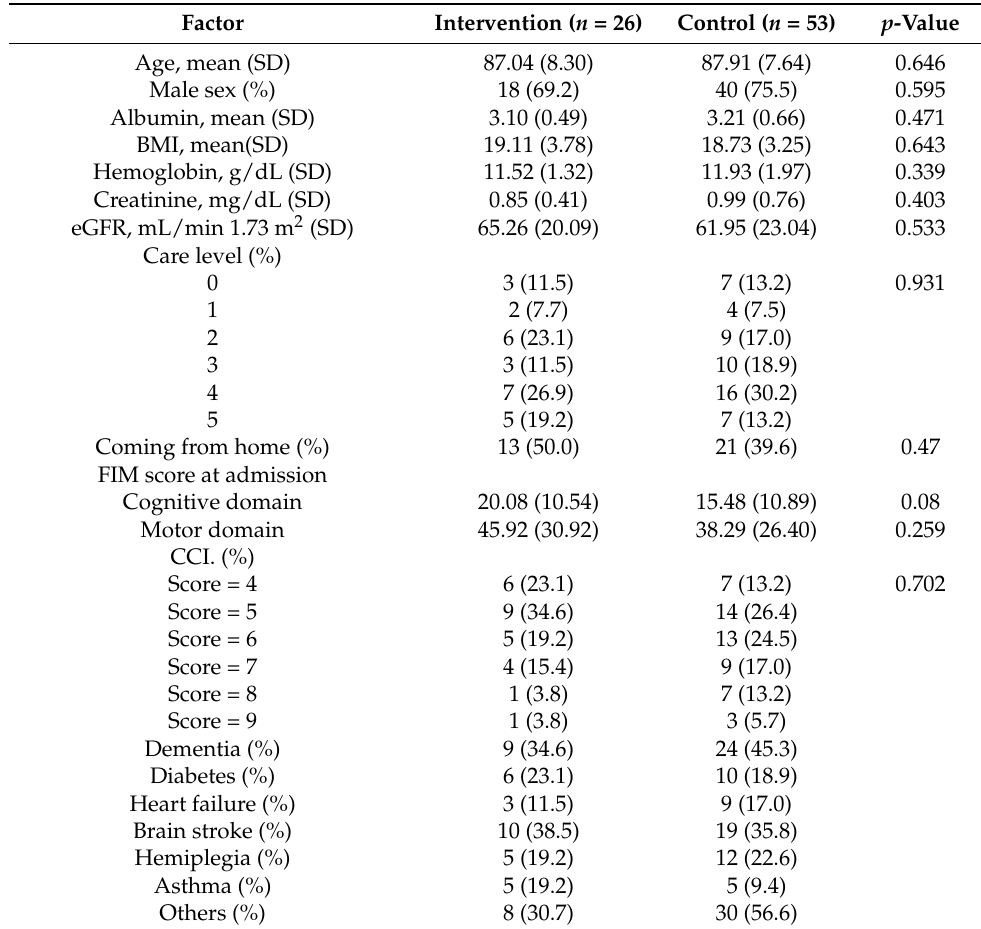
Table 1. Patient demographics.